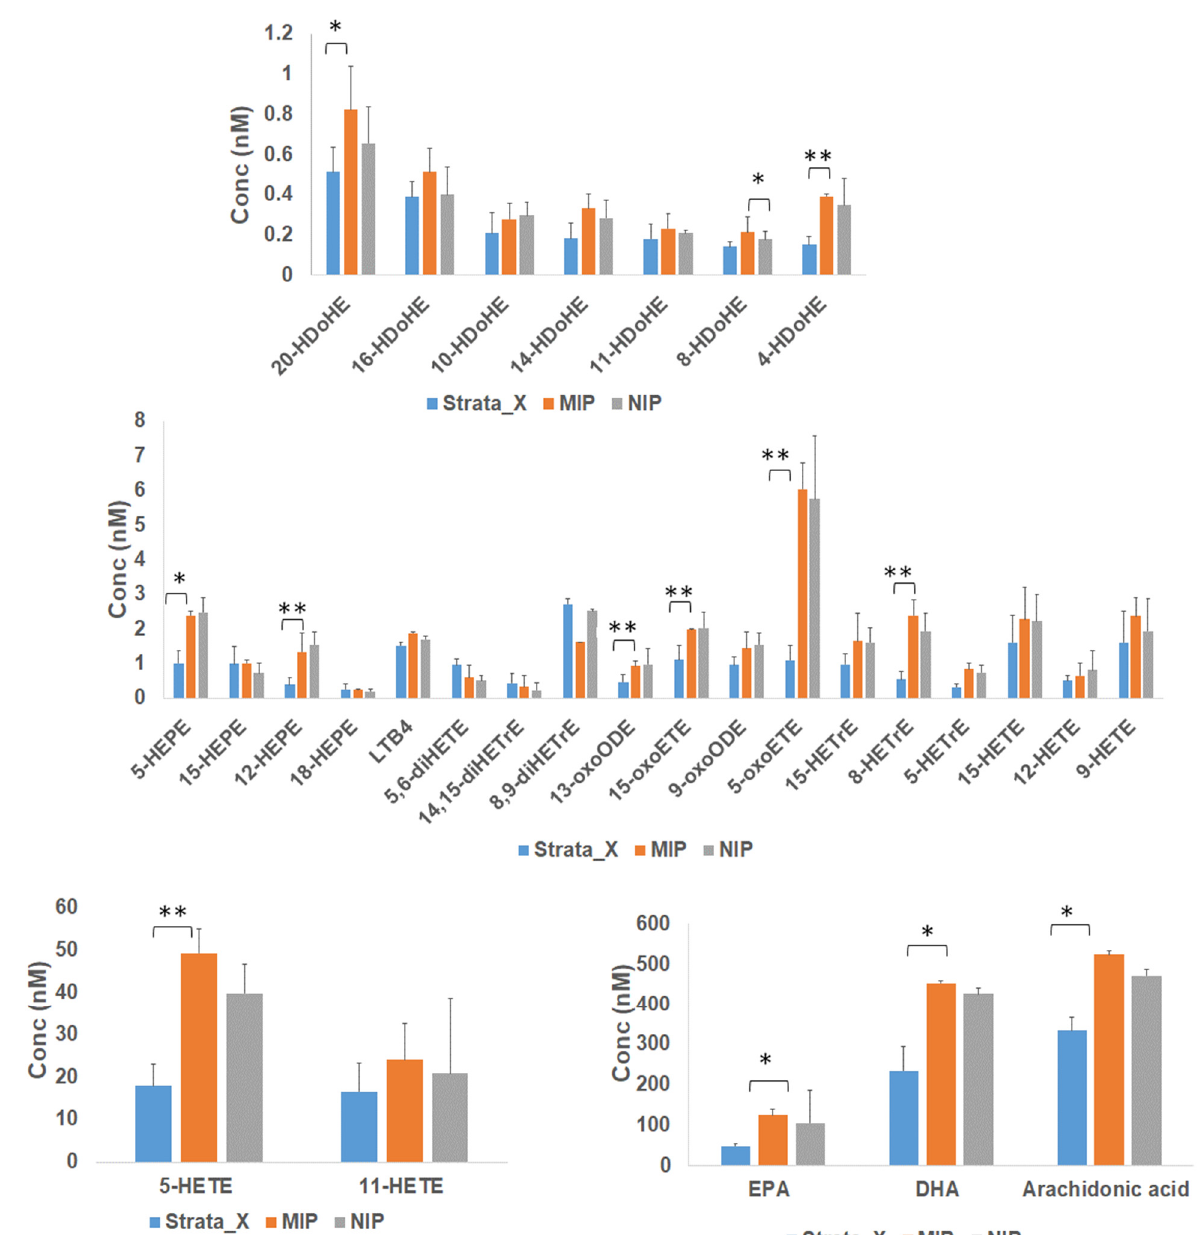
Figure 7. Comparison between MIP and NIP polymers and the commercially available Strata-X for lipid mediators enrichment from human plasma extracts. The same plasma extracts were used to test all the materials. Bar charts represent Mean ± SD from n = 3. SD—standard deviation. Stars represent significant differences calculated by Student’s t -test. * Indicates significant changes with a p value < 0.05. ** Indicates significant changes with a p value <